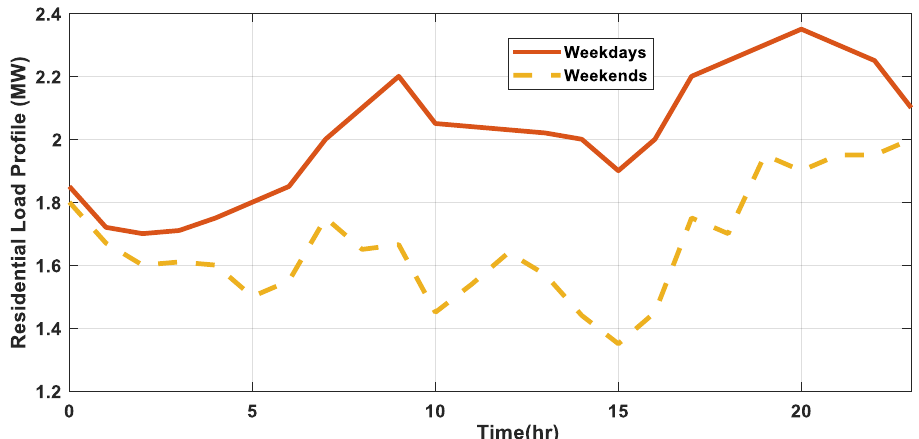
Figure 7. Residential load profile with different electric load profiles.